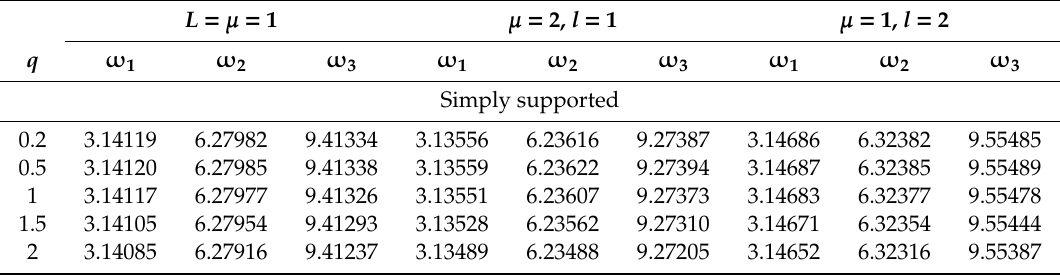
Table 8. E ff ect of the L / h and thickness variation on the first-three natural frequencies of a triclinic nanobeam for di ff erent boundary